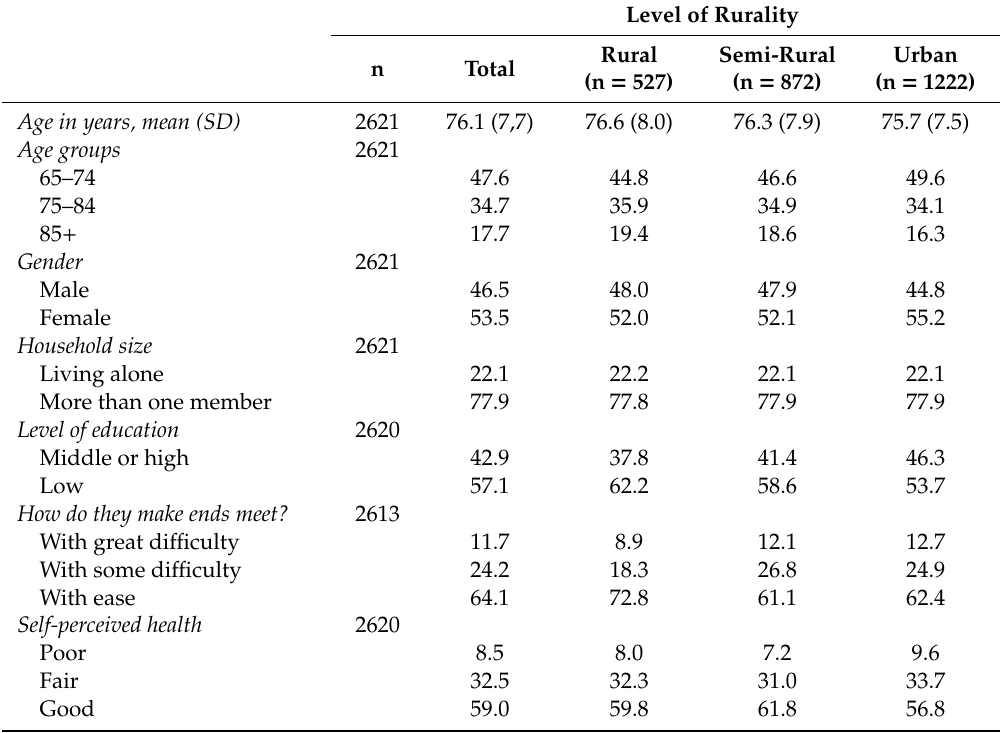
Table 1. Sample characteristics by level of rurality of home municipality. Individuals aged 65 +